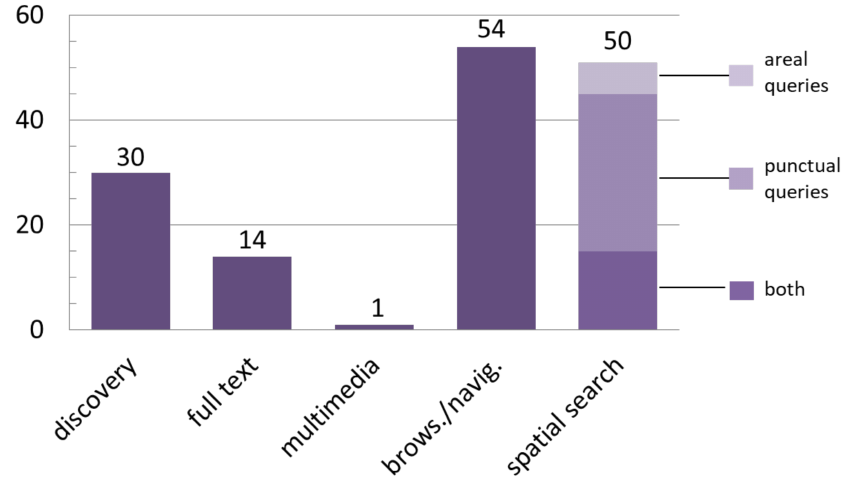
Figure 8. Chart representation of the results relative to the data search approaches.